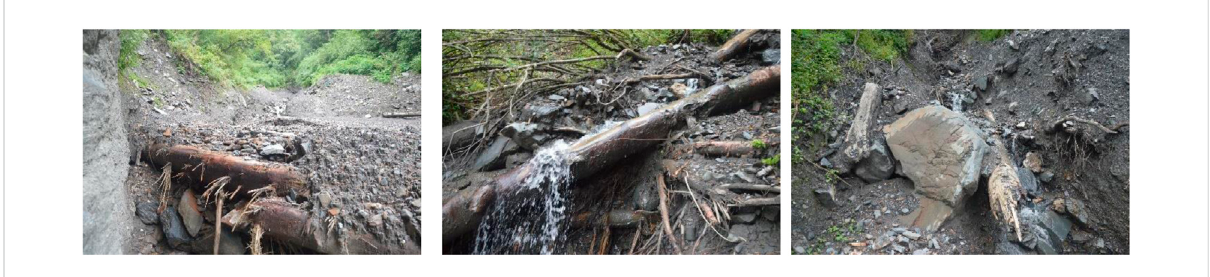
FIGURE 7 LW store and anchor sediment around in the nature fi eld.